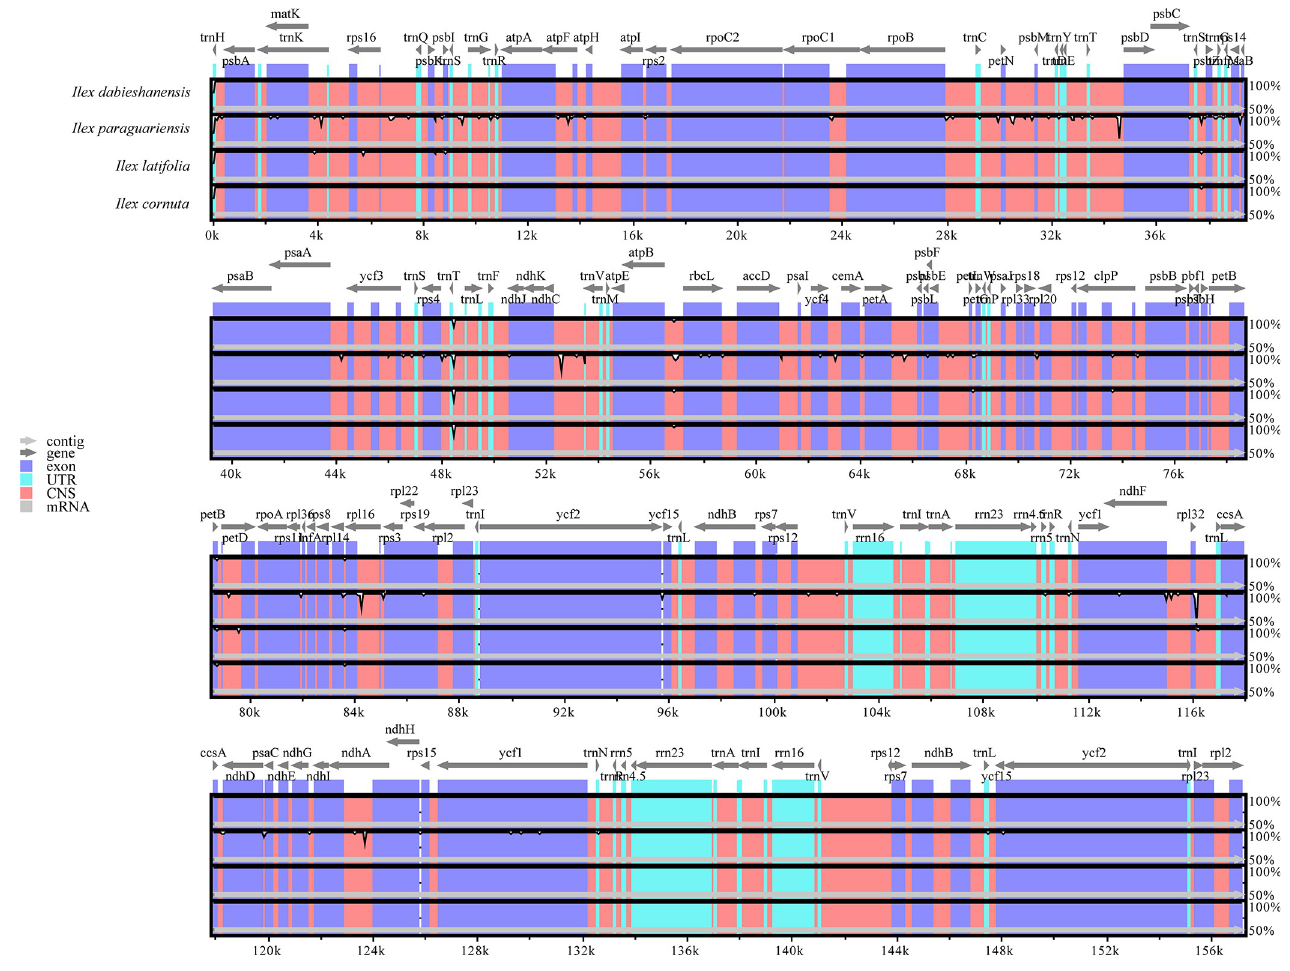
Fig 4. Chloroplast genome comparisons among four Ilex species by mVISTA. The chloroplast genome of I . dabieshanensis was used as a reference. Gray arrows above the alignment represent gene orientation. Different genome regions are color-coded as exons (purple bars), rRNA or tRNA (sky-blue bars), and non-coding sequences (CNS, pink bars). The horizontal axis indicates the coordinates within the chloroplast genome and vertical scale indicates the percentage of identity ranging from 50 to 100%. Regions with sequence variation among the four Ilex species were marked with white